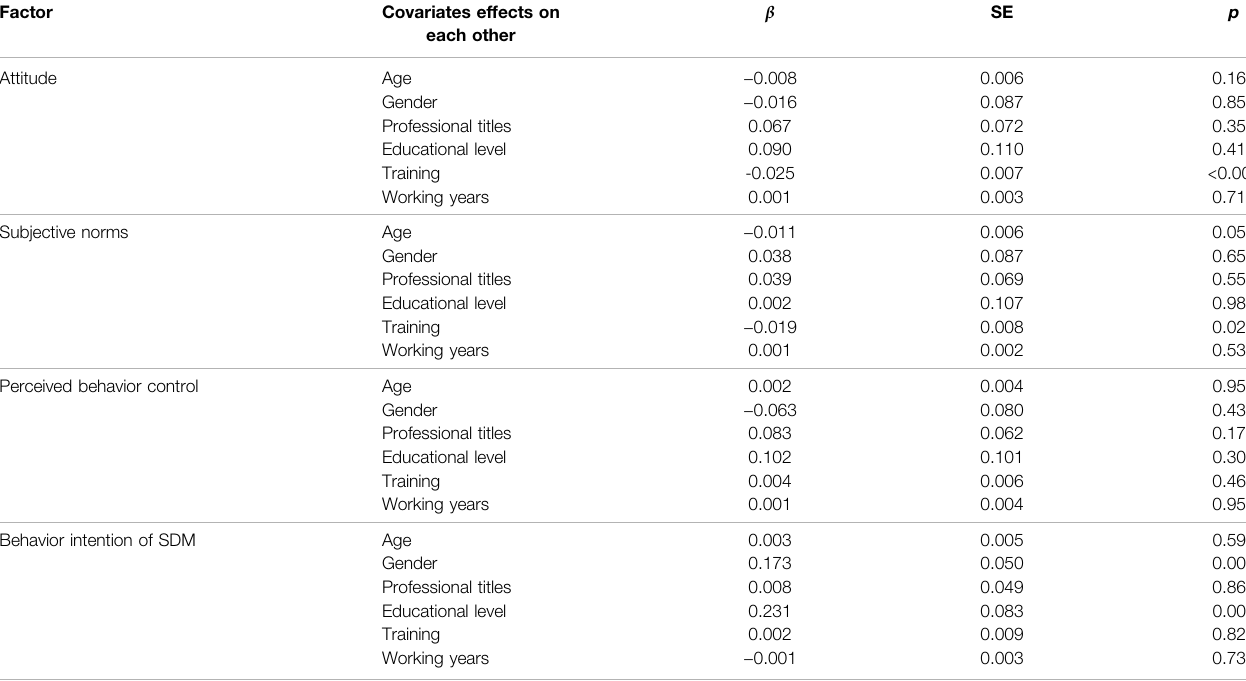
TABLE3 | MIMIC model results of covariates on the SDM behavior model Factor